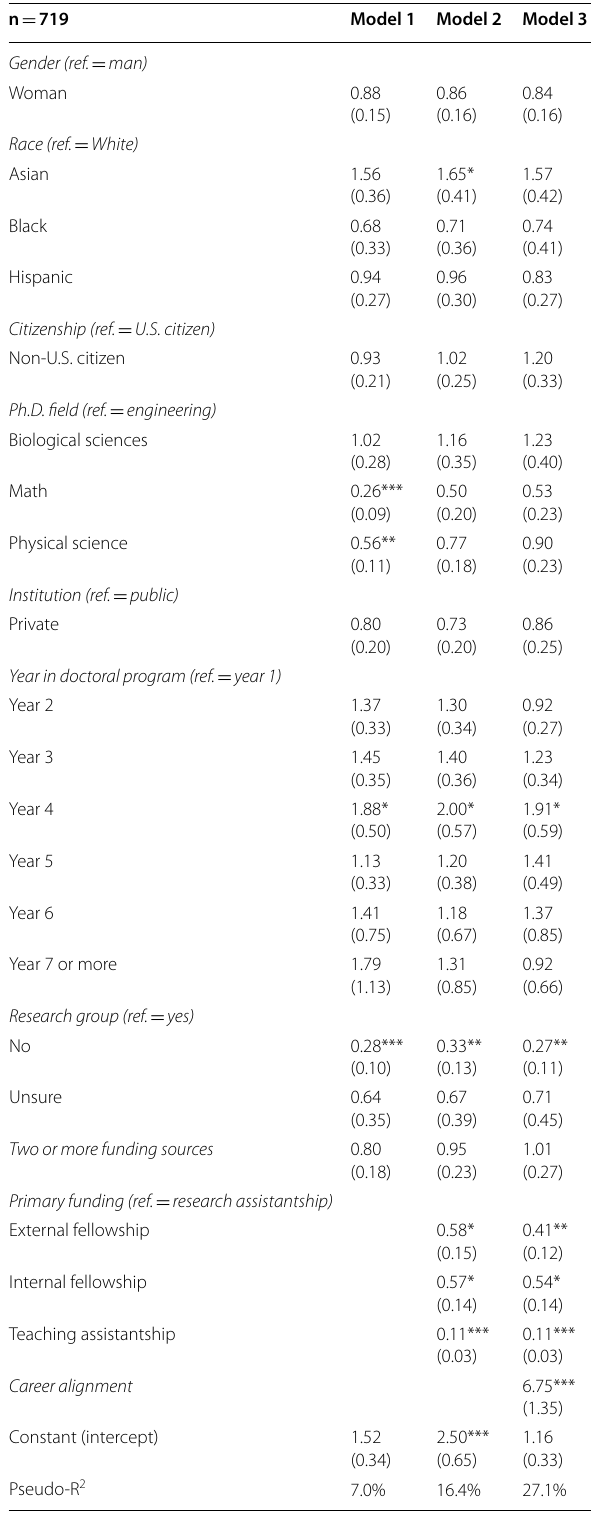
Table 4 Logistic regression of research